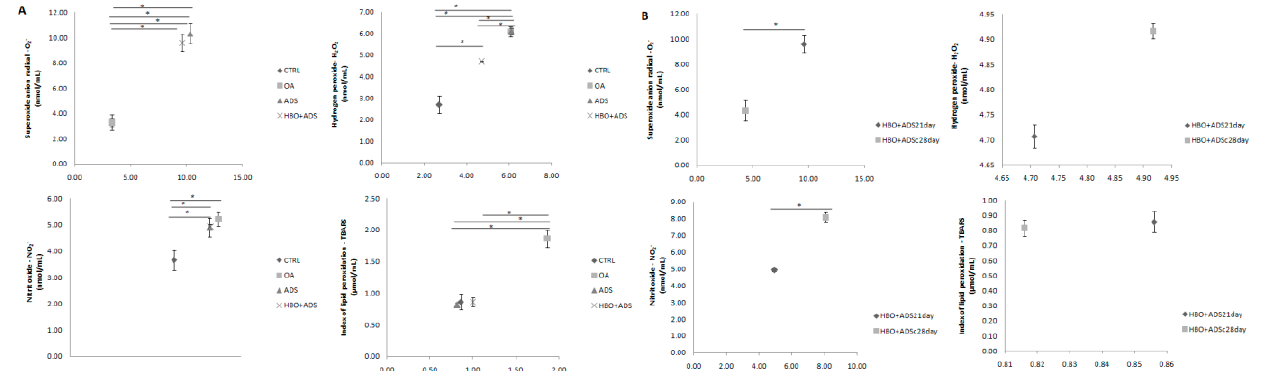
Figure 4. ( A ) Changes in the value of prooxidative markers in plasma samples between CTRL, OA, ADS and HBO+ADS groups measured as superoxide anion radical (O 2 − .), hydrogen peroxide (H 2 O 2 ), nitrites (NO 2 − ) and index of lipid peroxidation (TBARS). ( B ) Changes in the value of prooxidative markers in plasma samples between HBO+ADS 21days and HBO+ADS 28days groups measured as superoxide anion radical (O 2 − .), hydrogen peroxide (H 2 O 2 ), nitrites (NO 2 − ) and index of lipid peroxidation (TBARS). Values are presented as means ± mean standard error (SE). * p < 0.05 indicates statistically significant differences between groups.